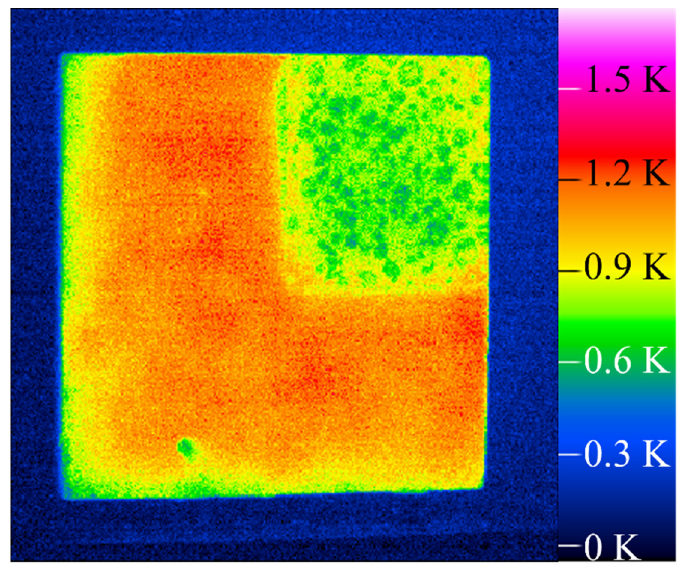
Figure 9. Difference thermogram of the type 1 sample after 20 s cooling down.